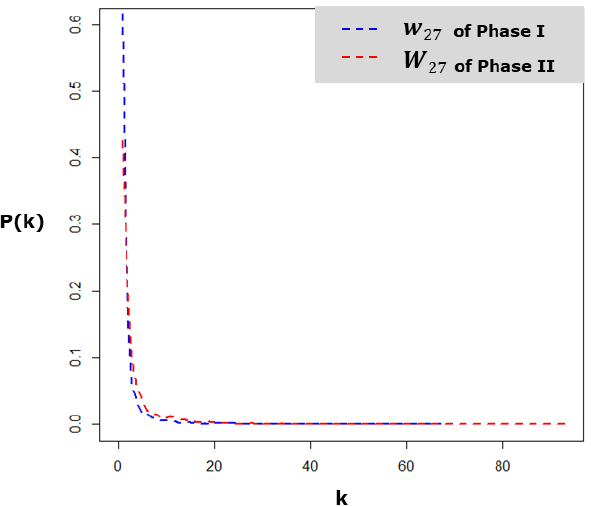
Figure 7. Degree distribution of networks during 𝑤 27 and 𝑊 27 .